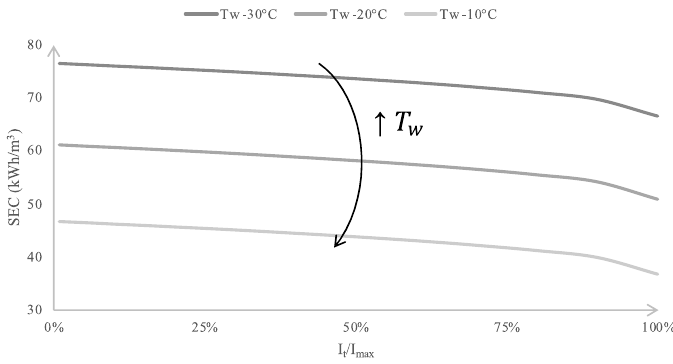
Figure 2. Specific energy consumption as a function of the filling level, 𝐼 (cid:3047) 𝐼 (cid:3040)(cid:3028)(cid:3051) ⁄ , for different temperatures, 𝑇 (cid:3050)